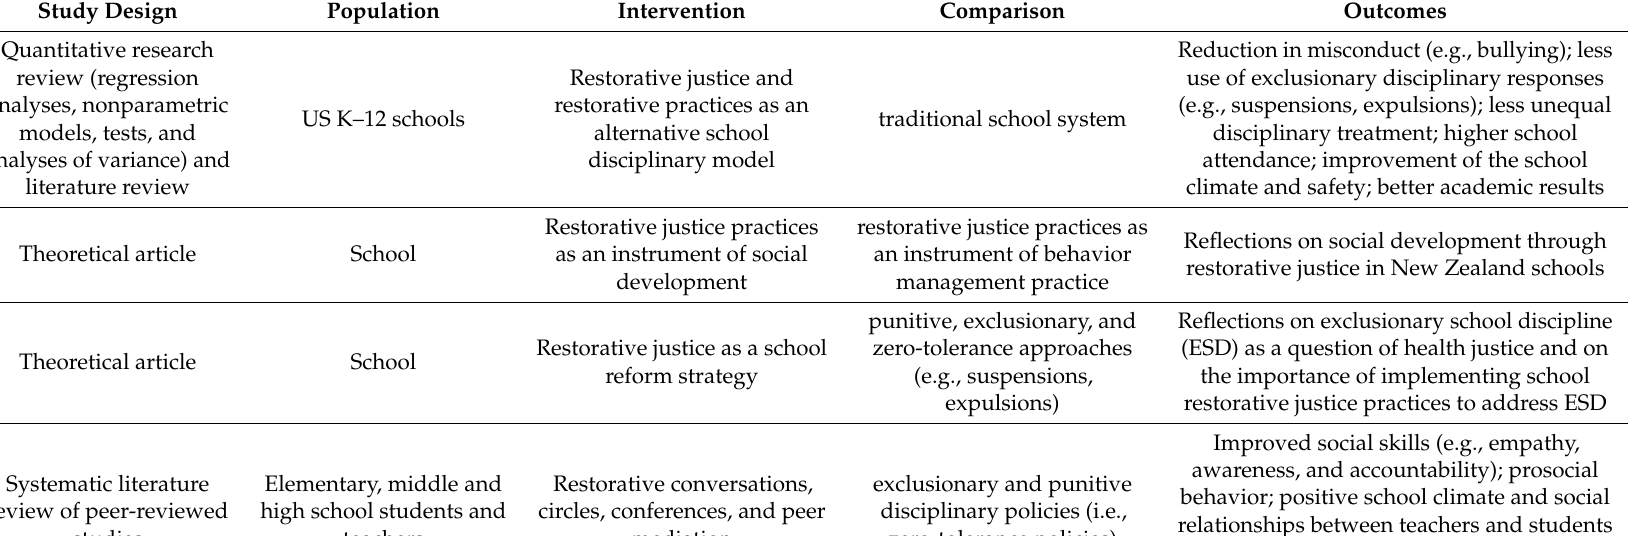
Table A1. Academic scientific literature excluded from the systematic review ( n =